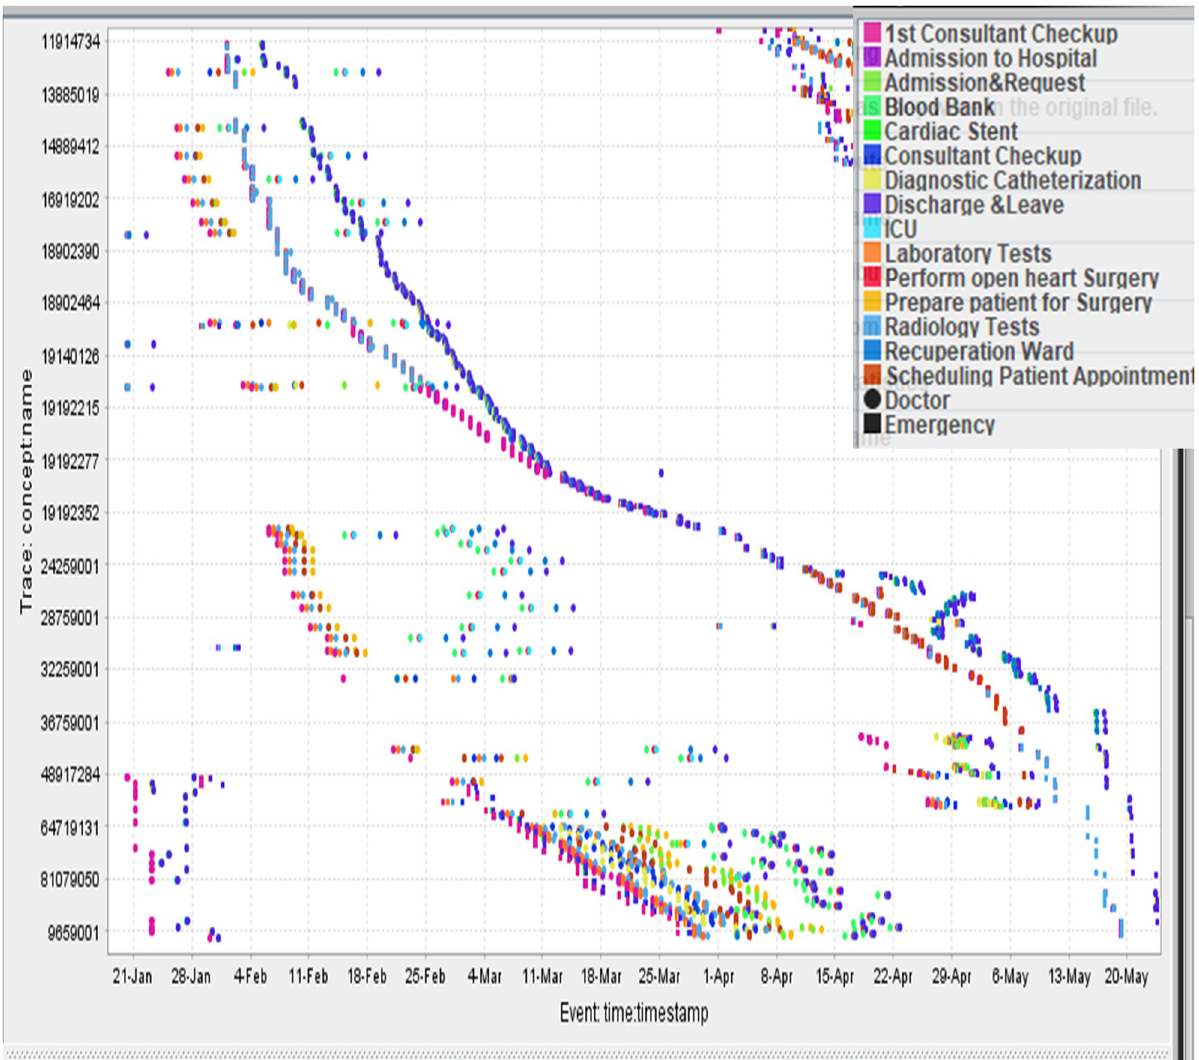
Fig 23. The dotted chart of whole event